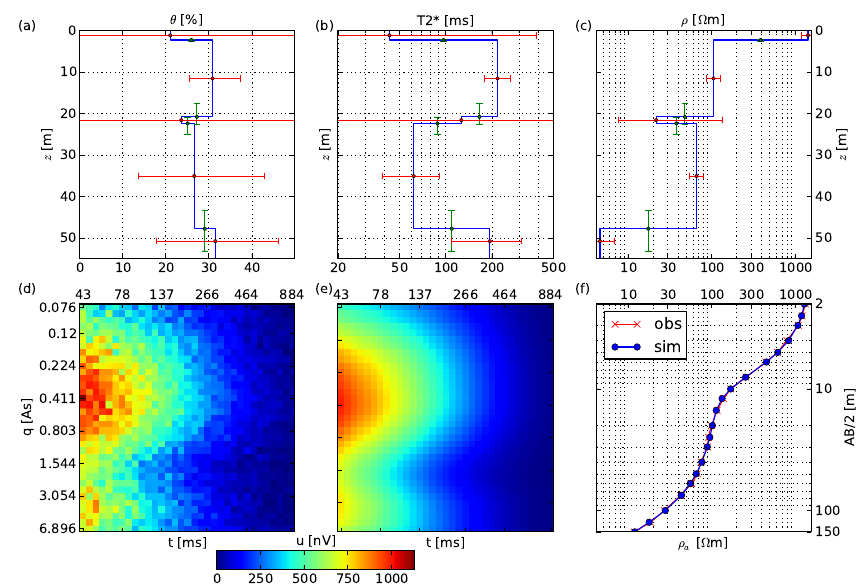
Fig. 3. Joint inversion results of the MRS and VES data at CL2 location: water content (a) , decay time (b) , and resistivity (c) , all as a function of depth, including uncertainty; MRS data cube observed (d) and simulated (e) ; and measured/modelled apparent resistivity (f) .